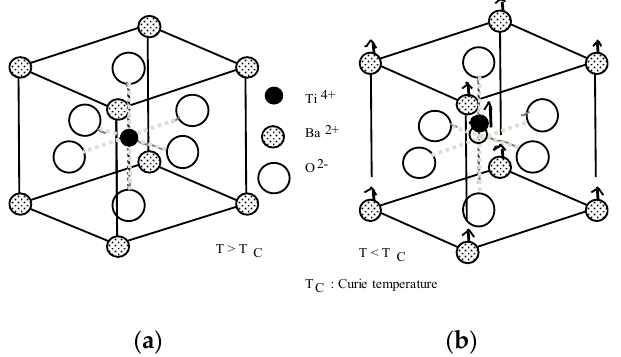
Figure 2. Crystal structures of barium titanate in the paraelectric state ( a ) and in the ferroelectric state ( b ).